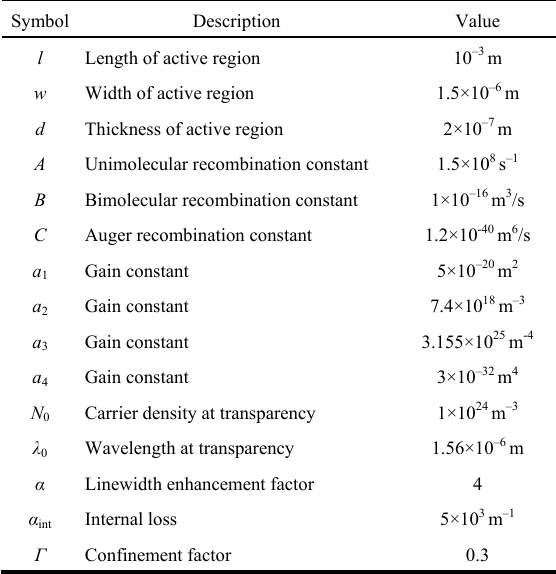
Table 1 SOA parameters used in